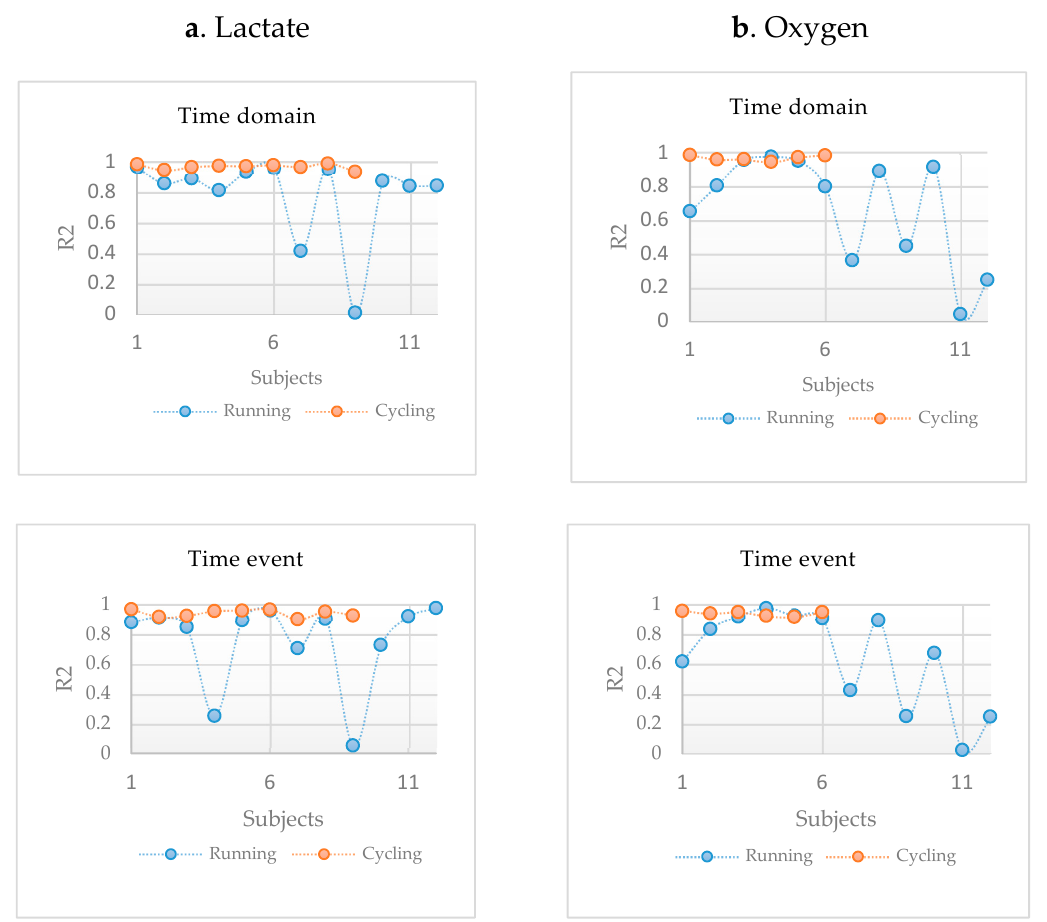
Figure 5. A comparison between R 2 estimates obtained using RF regression based on the time domain and time event features from cycling and running data. ( a ) depicts R 2 estimates for lactate. ( b ) depicts R 2 estimates for oxygen uptake.